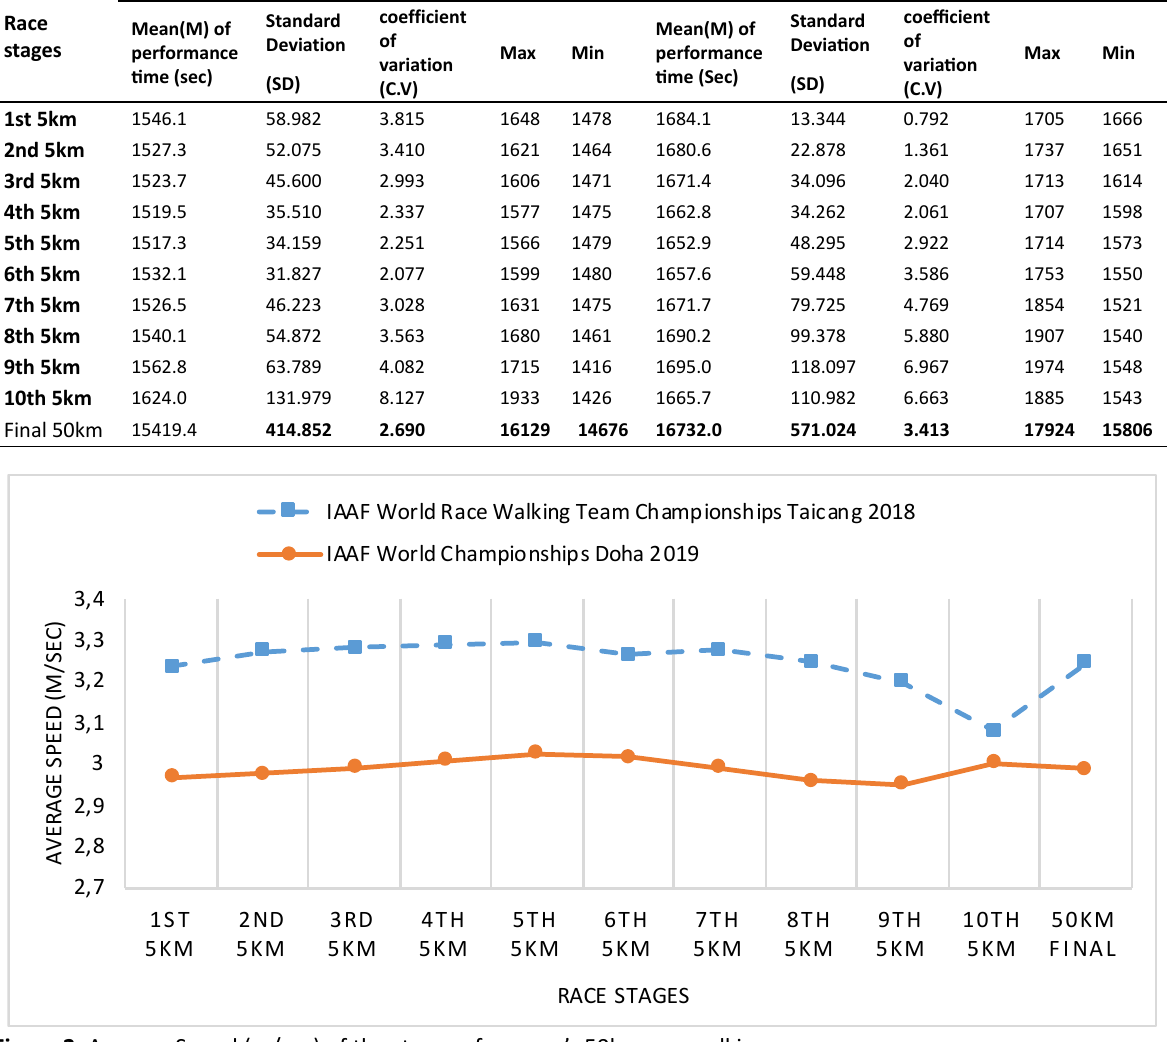
Figure 2. Average Speed (m/sec) of the stages of women’s 50km